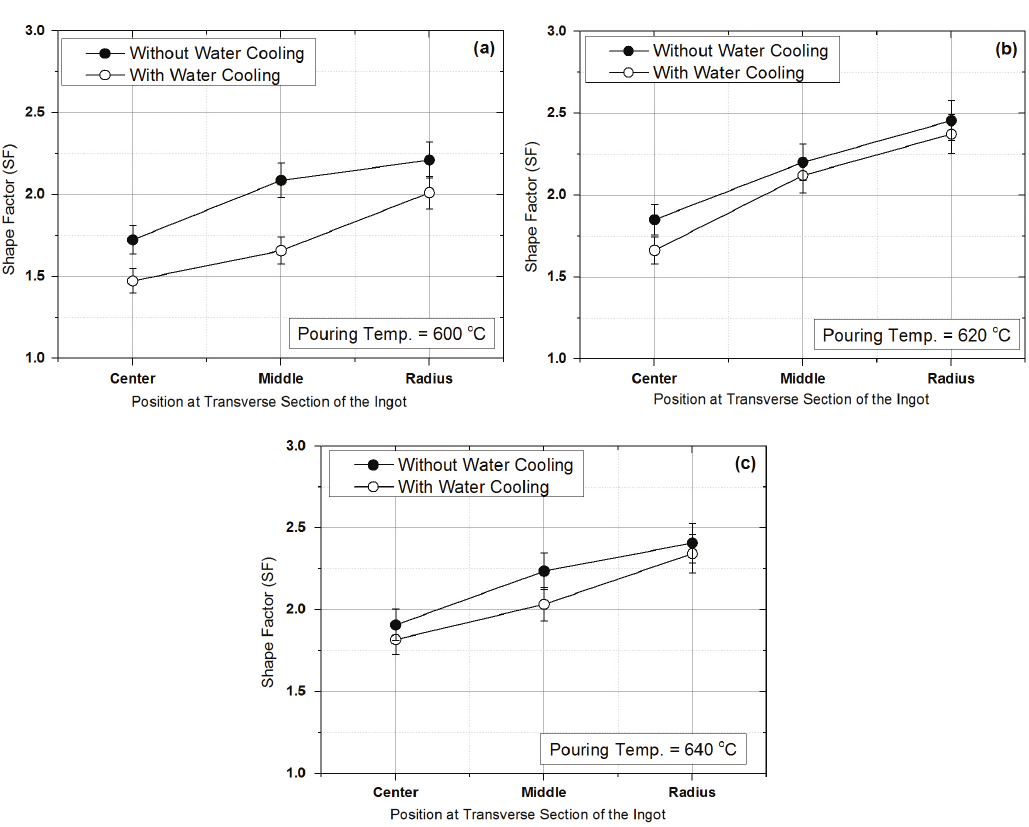
Figure 9. Variation of the shape factor of primary α-Al grains with the position at the transverse section of the